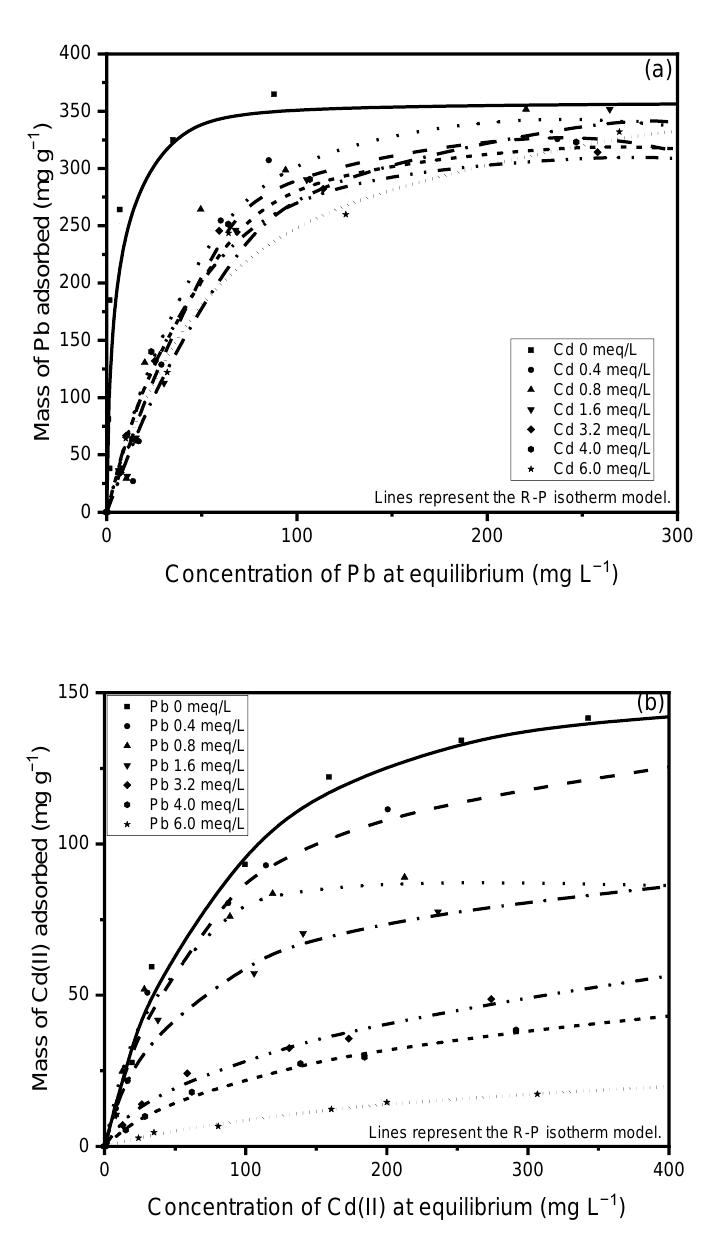
Figure 9. Binary adsorption isotherms of Cd(II)–Pb(II) on Sargassum biomass. ( a ) Cd(II) and ( b ) Pb(II) adsorption at pH = 5.0 and T = 25 °C.